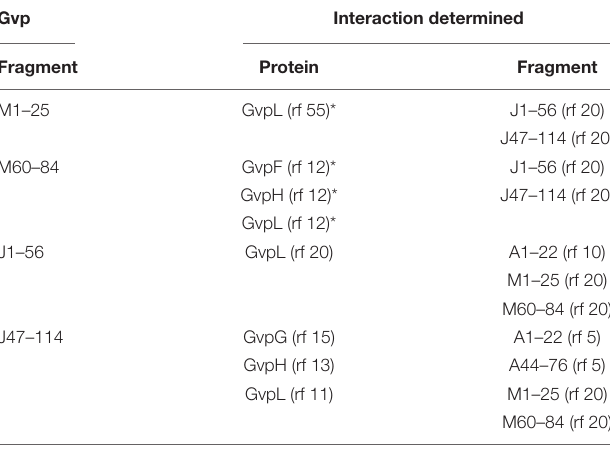
TABLE 2 | Interactions determined for GvpM, GvpJ, and